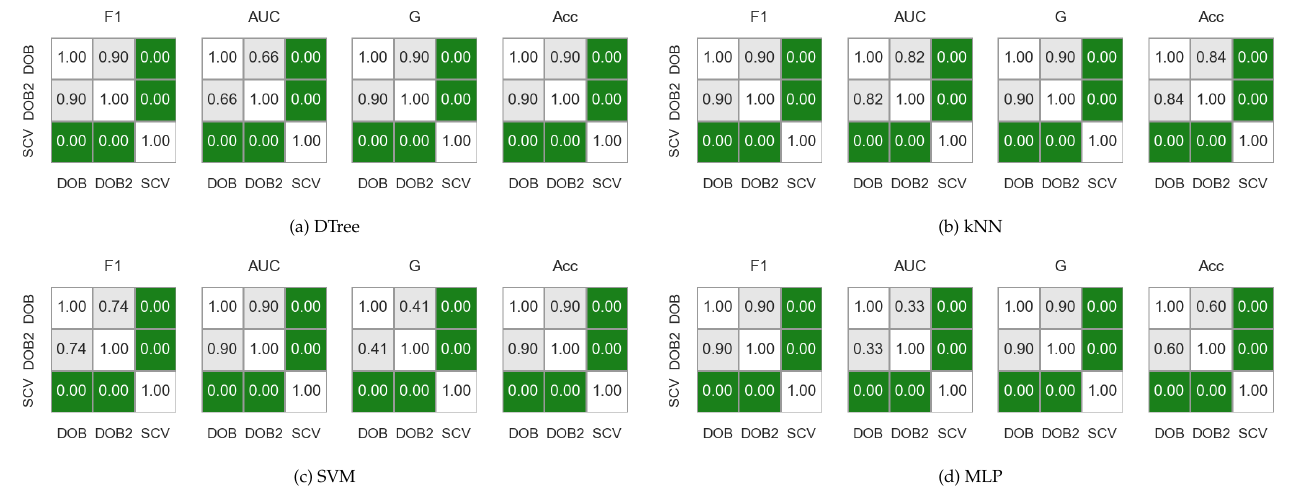
Figure 1. The result of the Nemenyi-test used to compare the classification performance scores obtained with different validations on the KEEL data sets. The oversampling was done by the named